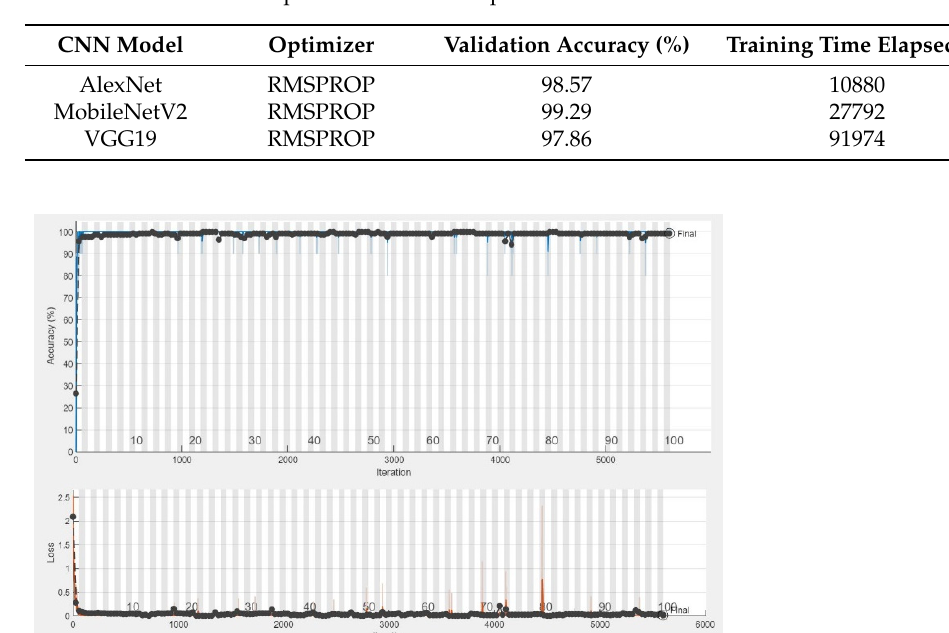
Figure 3. Block diagram of image classification using deep learning (CNN).